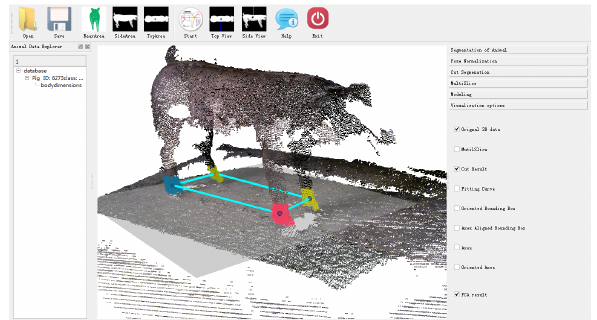
Figure 5. Visualization of entire pig segmentation pipeline.